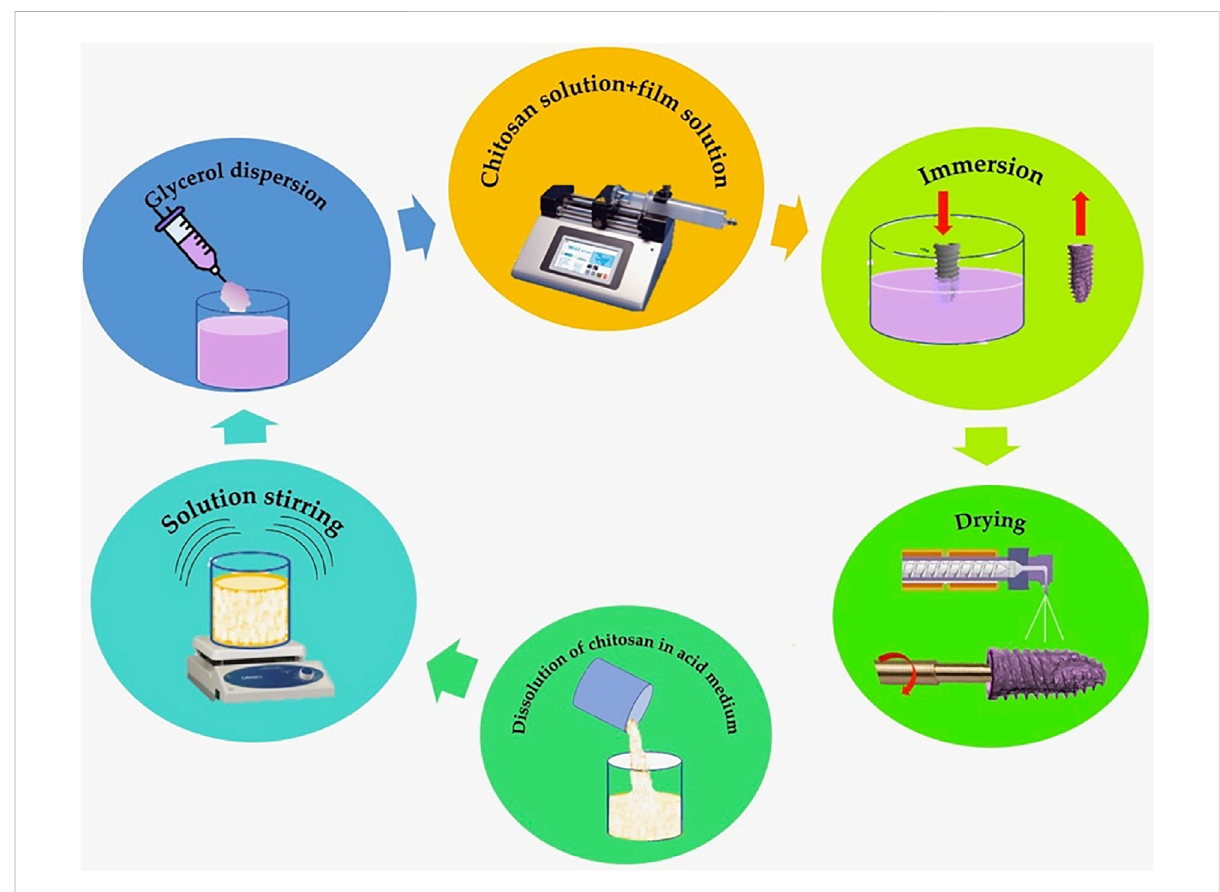
FIGURE 4 Modi fi ed Vakili and Zhang coating scheme for the immersion